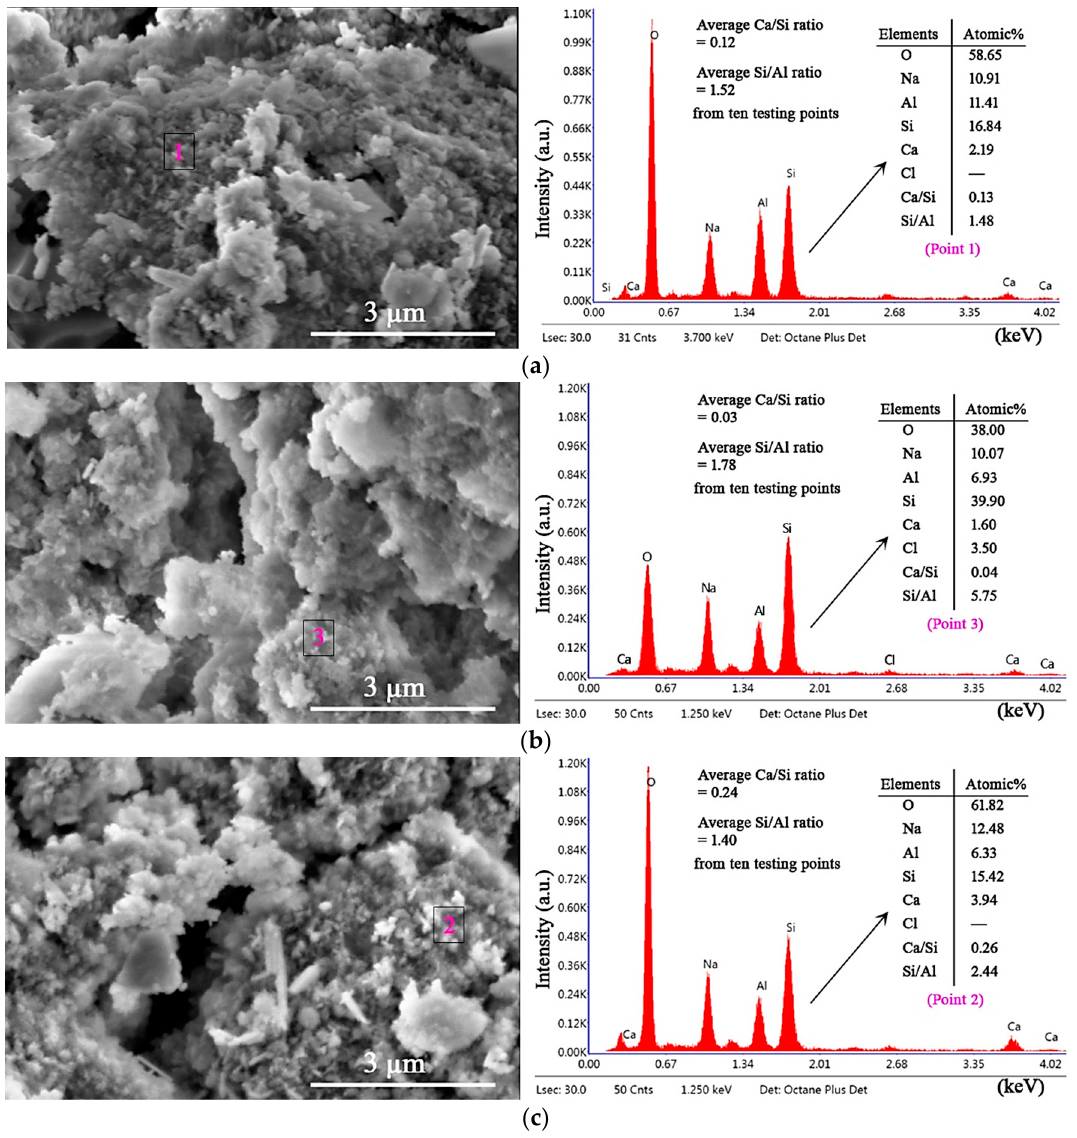
Figure 7. EDS spectra of representative SEM micro-areas for M10: ( a ) before attack, ( b ) HCl-attack for 28 d and ( c ) Na 2 SO 4 -attack for 28 d.